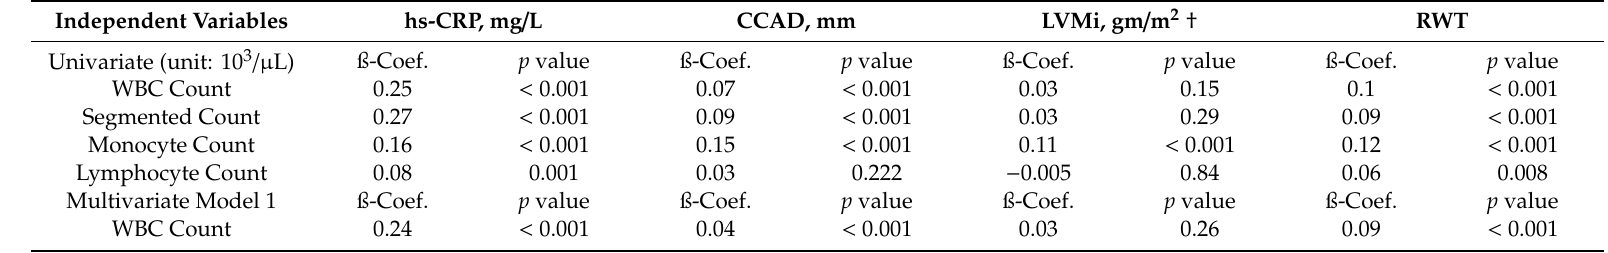
Table 2. Univariate and multivariate associations of various leukocyte counts with the inflammatory marker hs-CRP, carotid arterials, and ventricular structural